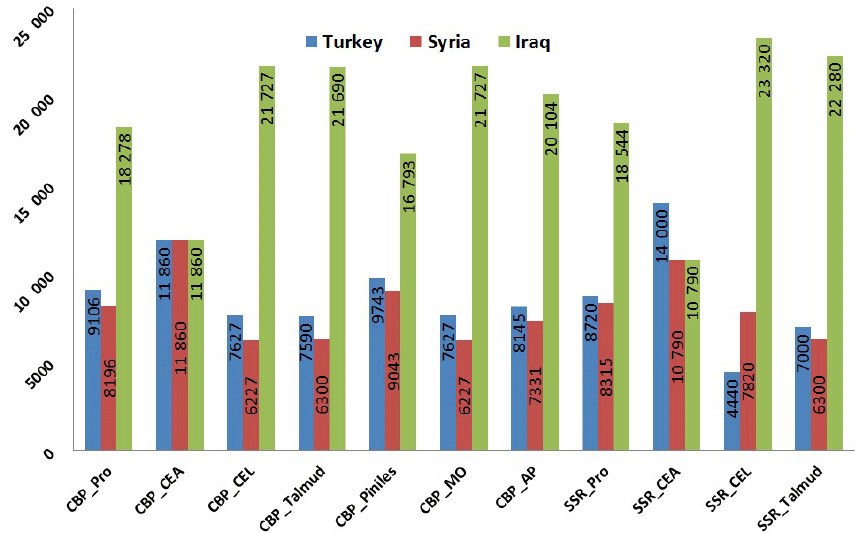
Figure 2. Reallocation of the Euphrates River among three riparian countries by Classic Bankruptcy Rules (CBR) and Sequential Sharing Rules (SSR)